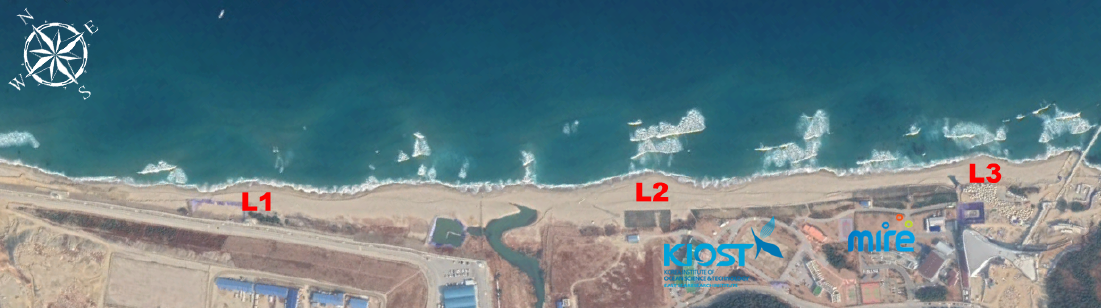
Figure 13. Satellite image captured from Google Earth near L1–L3 measured on 13 February 2019. The image shows that the waves are breaking at the locations where the sandbar horns developed, and the shoreline was advanced at the corresponding locations.